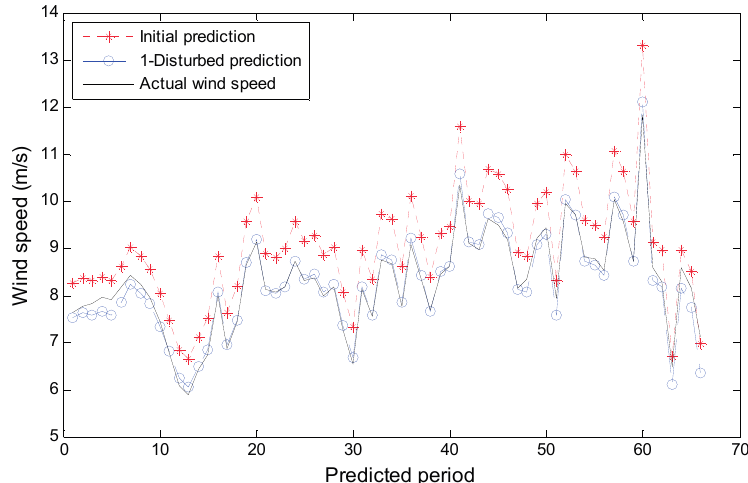
Figure 7. Wind speed forecasting results of the linear polynomial generating model when Rayleigh number equals